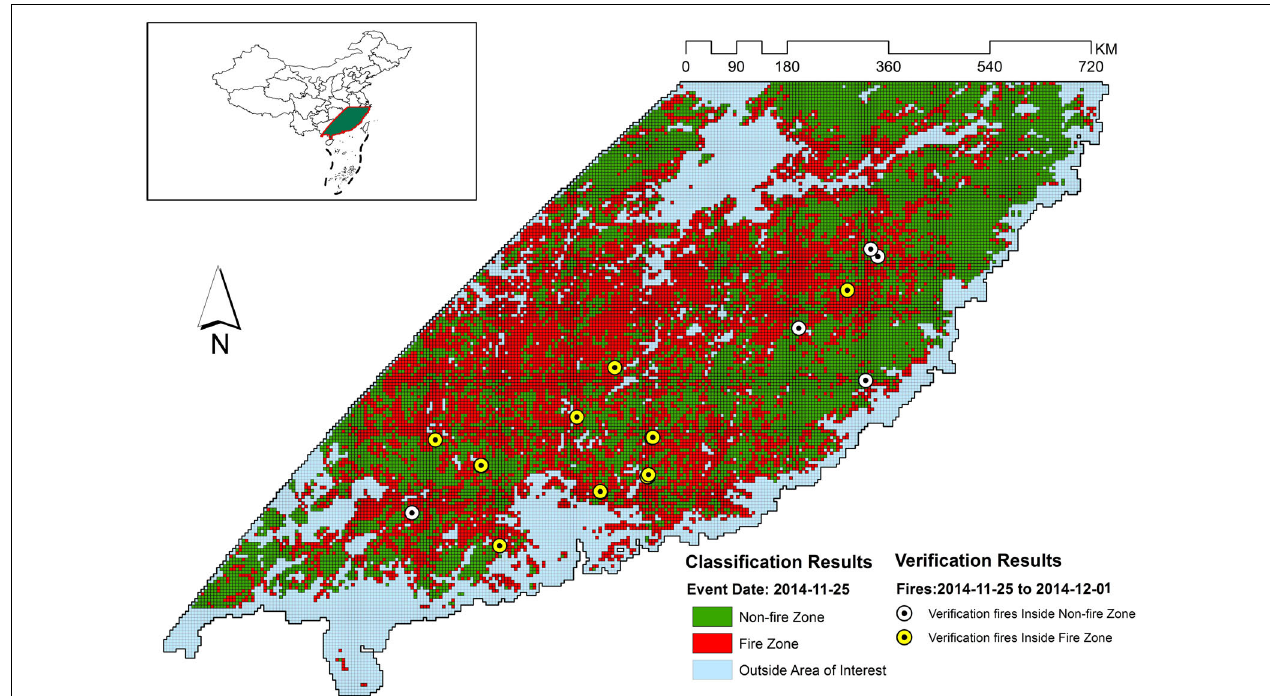
FIGURE 11 | Classification and verification results for 2014-11-25.